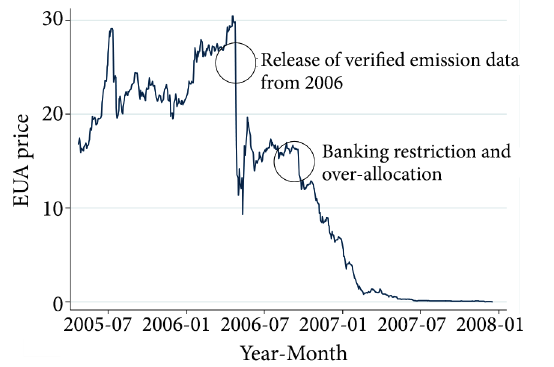
Figure 2. Daily EUA Price from the phase I of EU